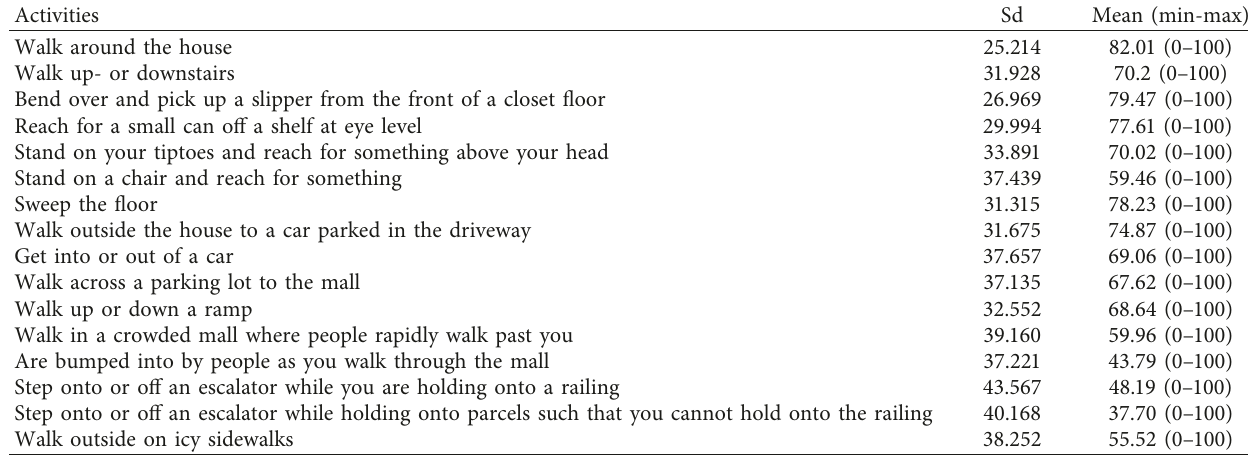
Table 1: Activity balance confidence levels based on the ABC scale.